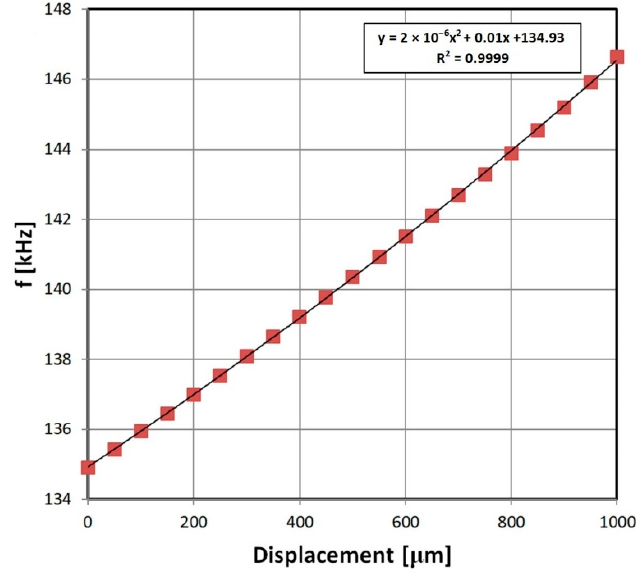
Figure 9. Exemplary results of inductive displacement sensor with 555 transducer output characteristics.